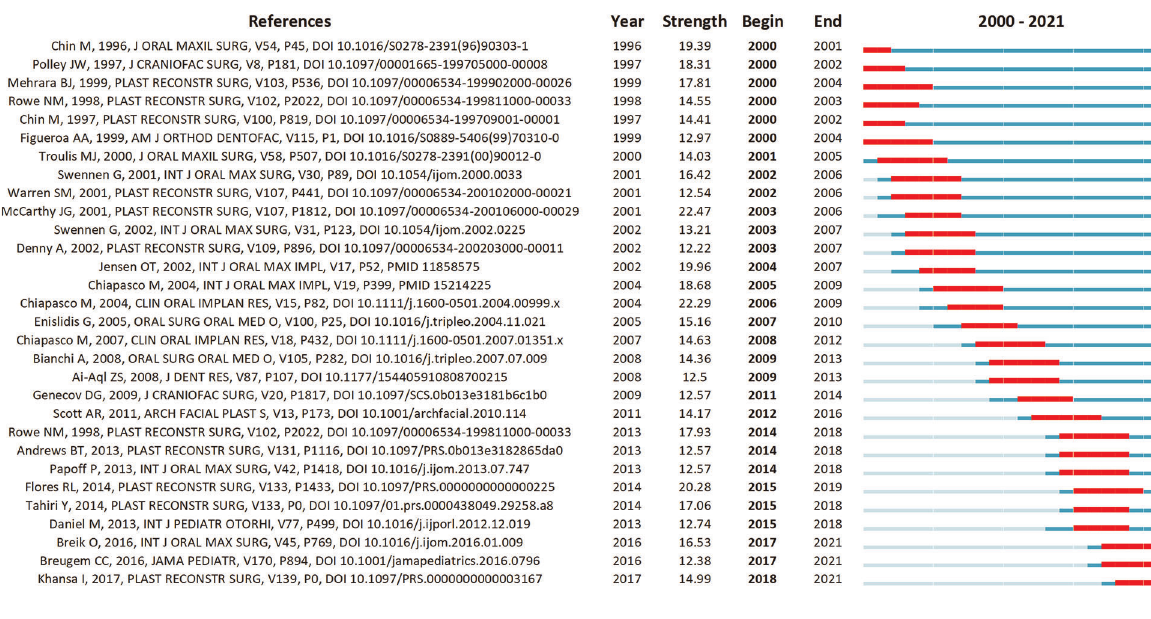
FIGURE 4 The top 30 cited references with the strongest burst.